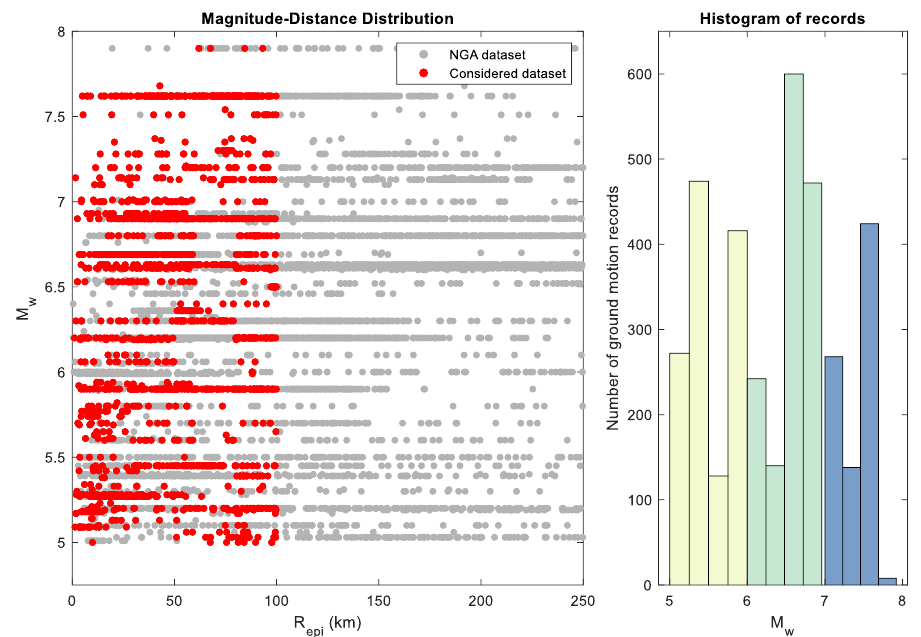
Figure 1. ( Left ) Magnitude M w versus epicentral distance R epi for strong-motion recordings in the NGA west 2 database (gray dots). Red points show the dataset used in this study, focusing on the near-fault region with maximum epicentral distance R epi = 100 km, leading to 3582 records from 105 events. We consider only magnitudes M w > 5 to ensure a significant response of the structure; 41% of records are from reverse-slip, 22% each from strike-slip and oblique-slip and remaining from normal slip events. ( Right ) Histogram of records sorted with respect to magnitude. The highest strong motion records fall in 6.0 to 7.0 magnitude category, followed by 7.0 to 8.0 range.